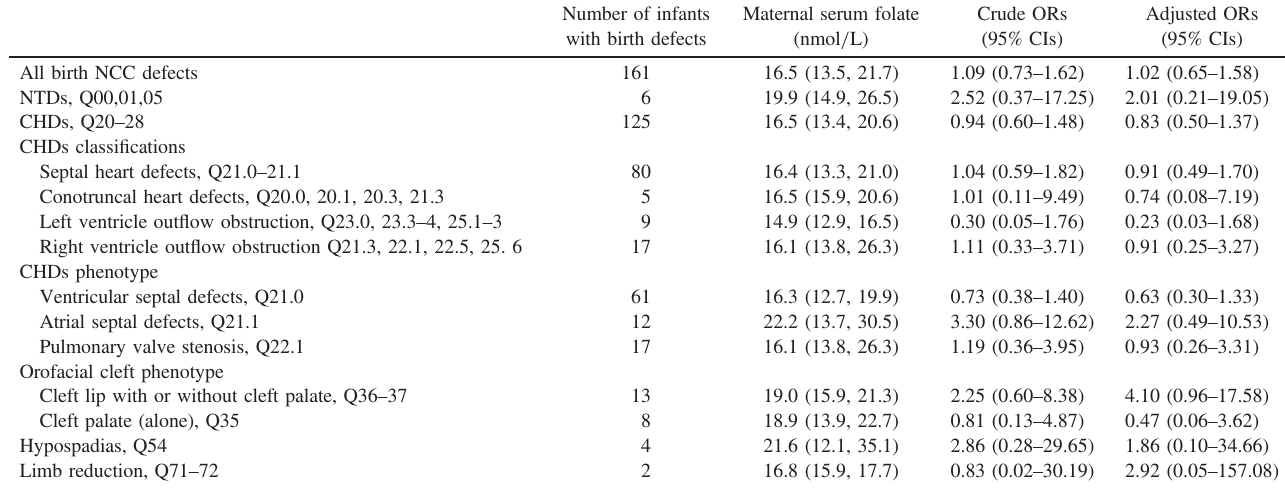
Number of infants Maternal serum folate Crude ORs Adjusted ORs with birth defects (nmol = L) (95% CIs) (95% CIs)